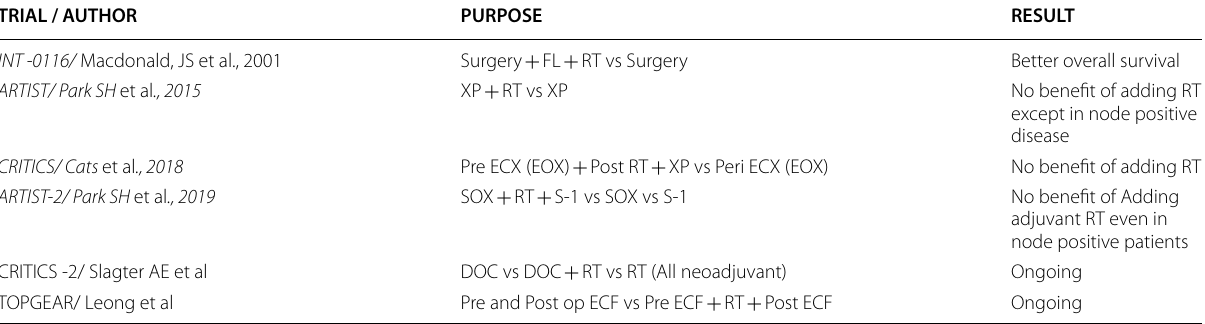
Table 3 Neoadjuvant/ Adjuvant